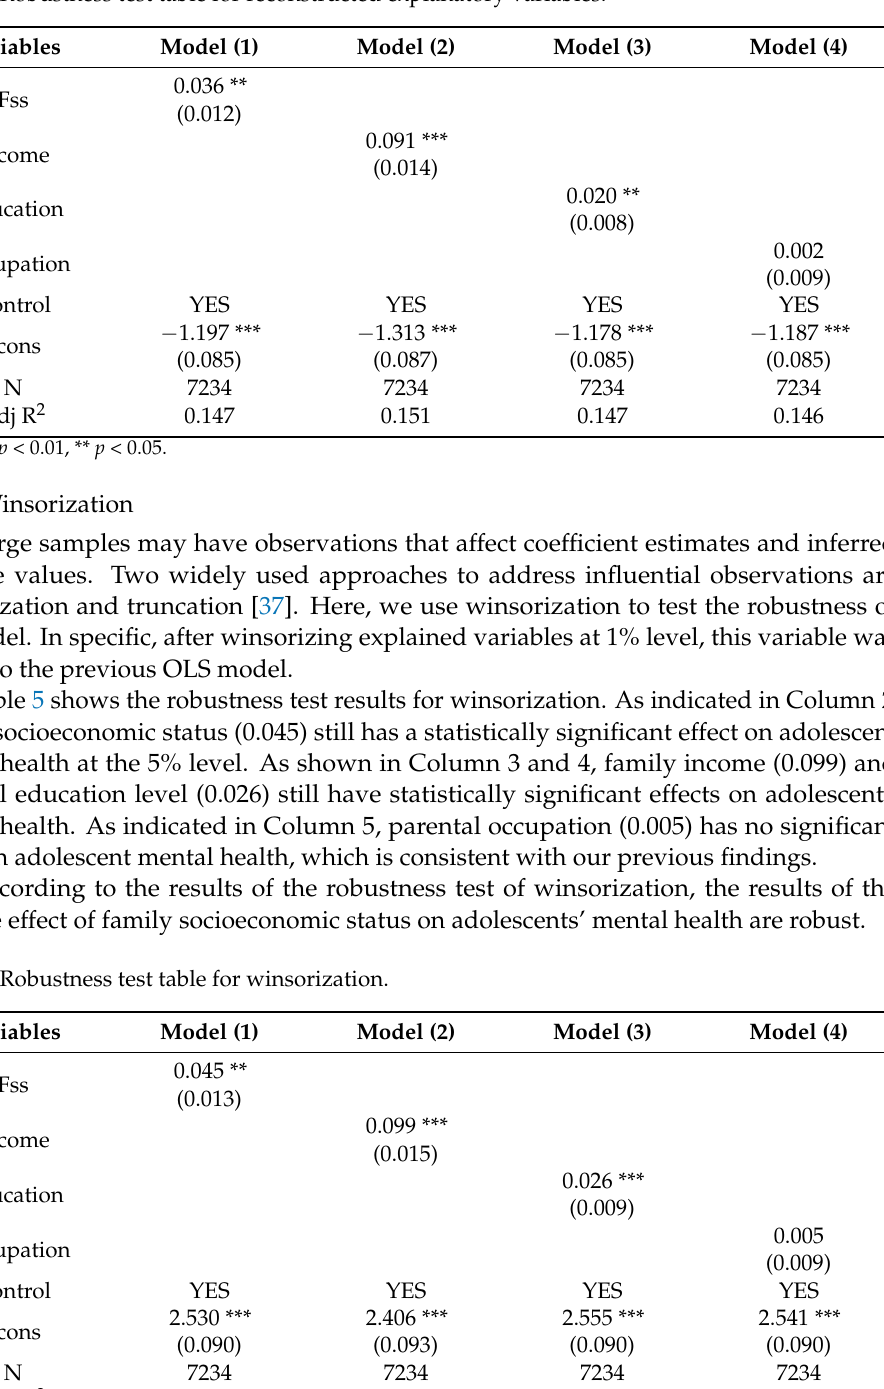
Table 4. Robustness test table for reconstructed explanatory variables.